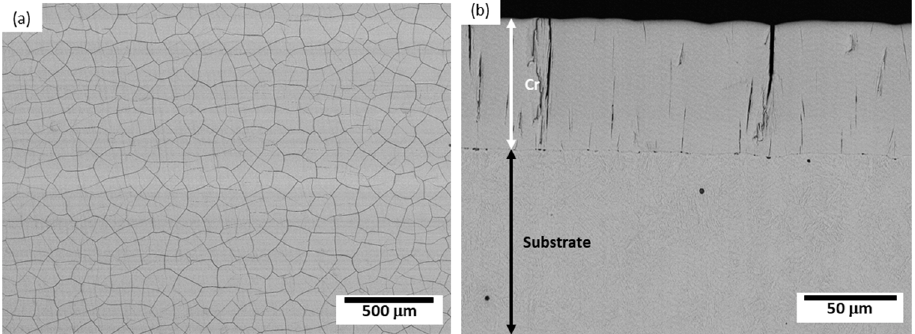
Figure 1. SEM micrographs of the Cr(III) coating. ( a ) A top view of the surface and ( b ) a cross-